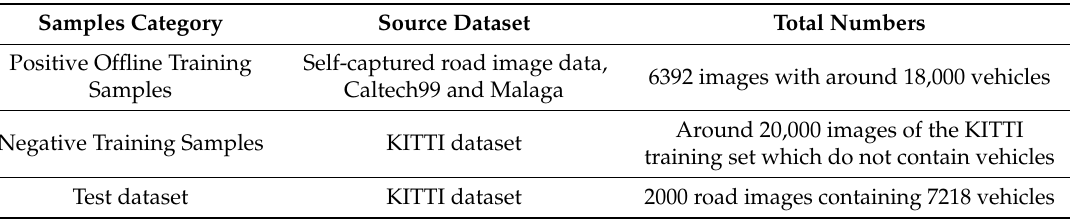
Table 2. Experiment dataset